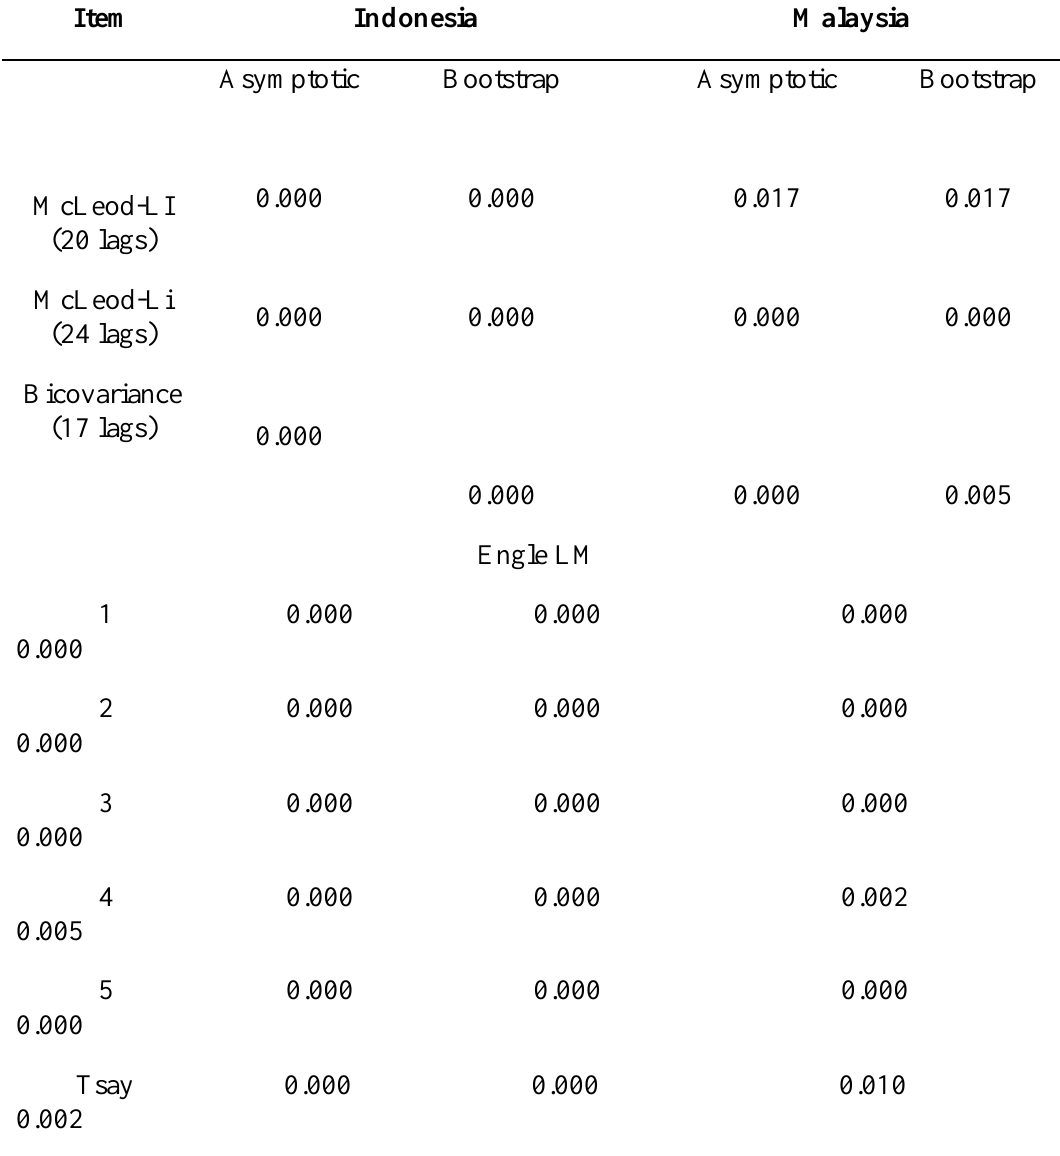
Table 5.A. Nonlinearity Test on AR ( p )